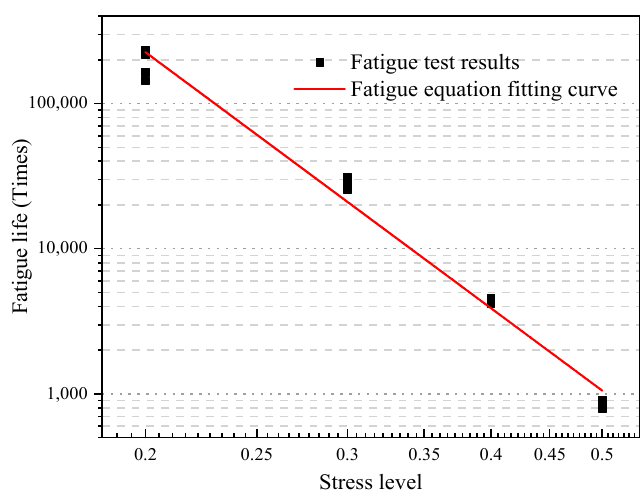
Figure 9. The law of fatigue life changing with the stress level. Table 10. The fatigue life predicted results by using GA-BPNN.